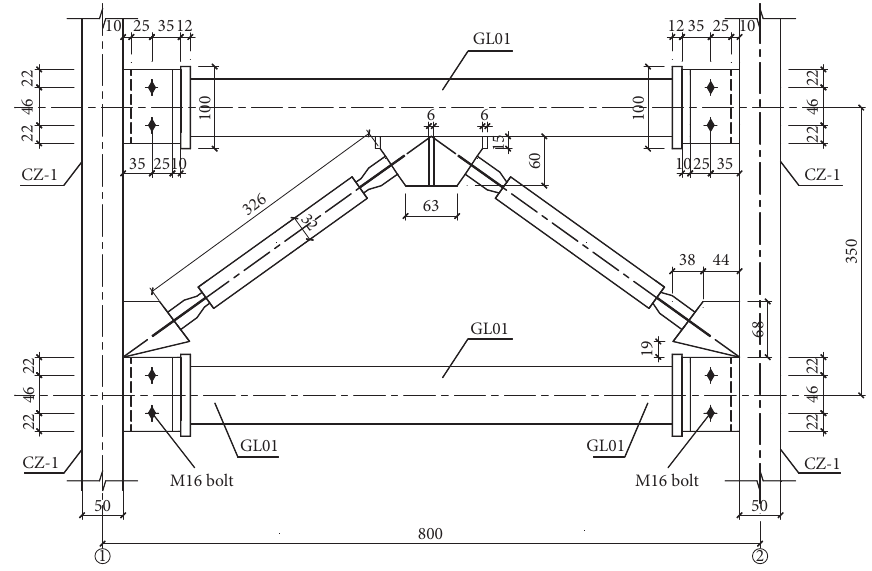
Figure 6: Single-layer brace frame.